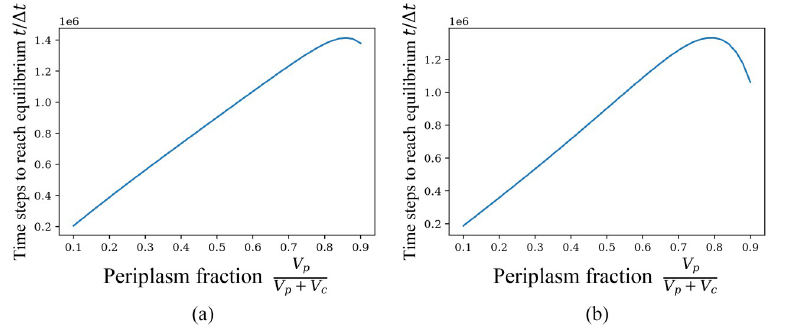
Fig 7. Time to reach equilibrium with the variation of periplasm fraction V p , ξ = 0. The sum of volumes of V p þ V c periplasm and cytoplasm is fixed, V + V = 2 × 10 6 / C 0 . (a) Initial particle concentration fixed, and the initial conditions c p are like n ¼ 10 3 ; n ¼ 0 ; N H þ = V ¼ C = 10 ; N H þ = V ¼ C = 1000 ; N L = V ¼ C = 40 ; N L = V ¼ 3 C = 40 . (b) Initial 1 0 0 0 0 k 6¼ 1 p c p c p c p c particle population fixed, and the initial conditions are like n ¼ 10 3 ; n ¼ 0 ; N H þ ¼ 10 5 ; N L ¼ 2 : 5 � 10 4 ; 1 k 6¼ 1 p p ¼ 7 : 5 � 10 4 ; N H þ ¼ 10 3 N L c c